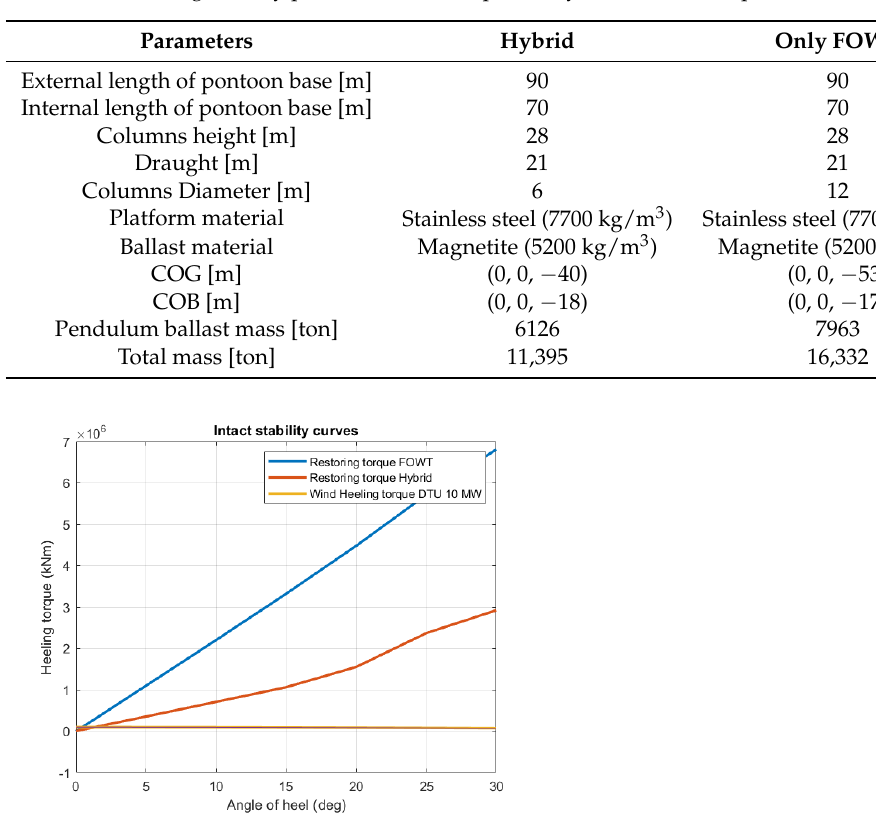
Figure 16. Nautilus intact stability curve: comparison between in-house tool and commercial software Orca-3D. Table 6. Mass and geometry parameters of the optimal hybrid and FOWT platform configurations.